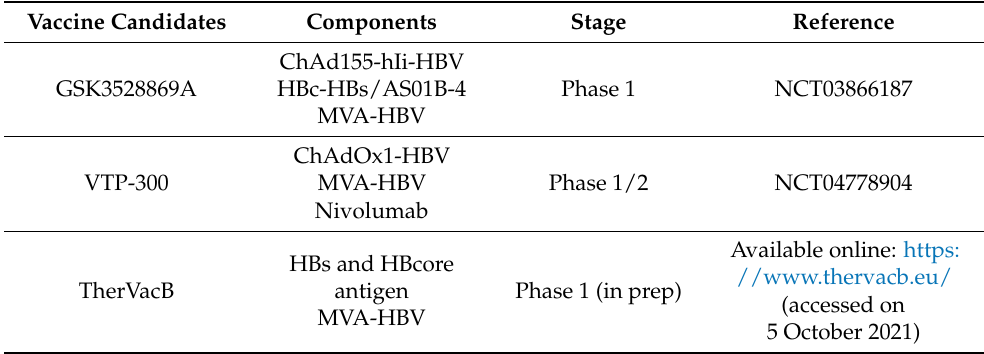
Table 1. List of current clinical trials investigating heterologous prime boost therapeutic vaccines against chronic hepatitis